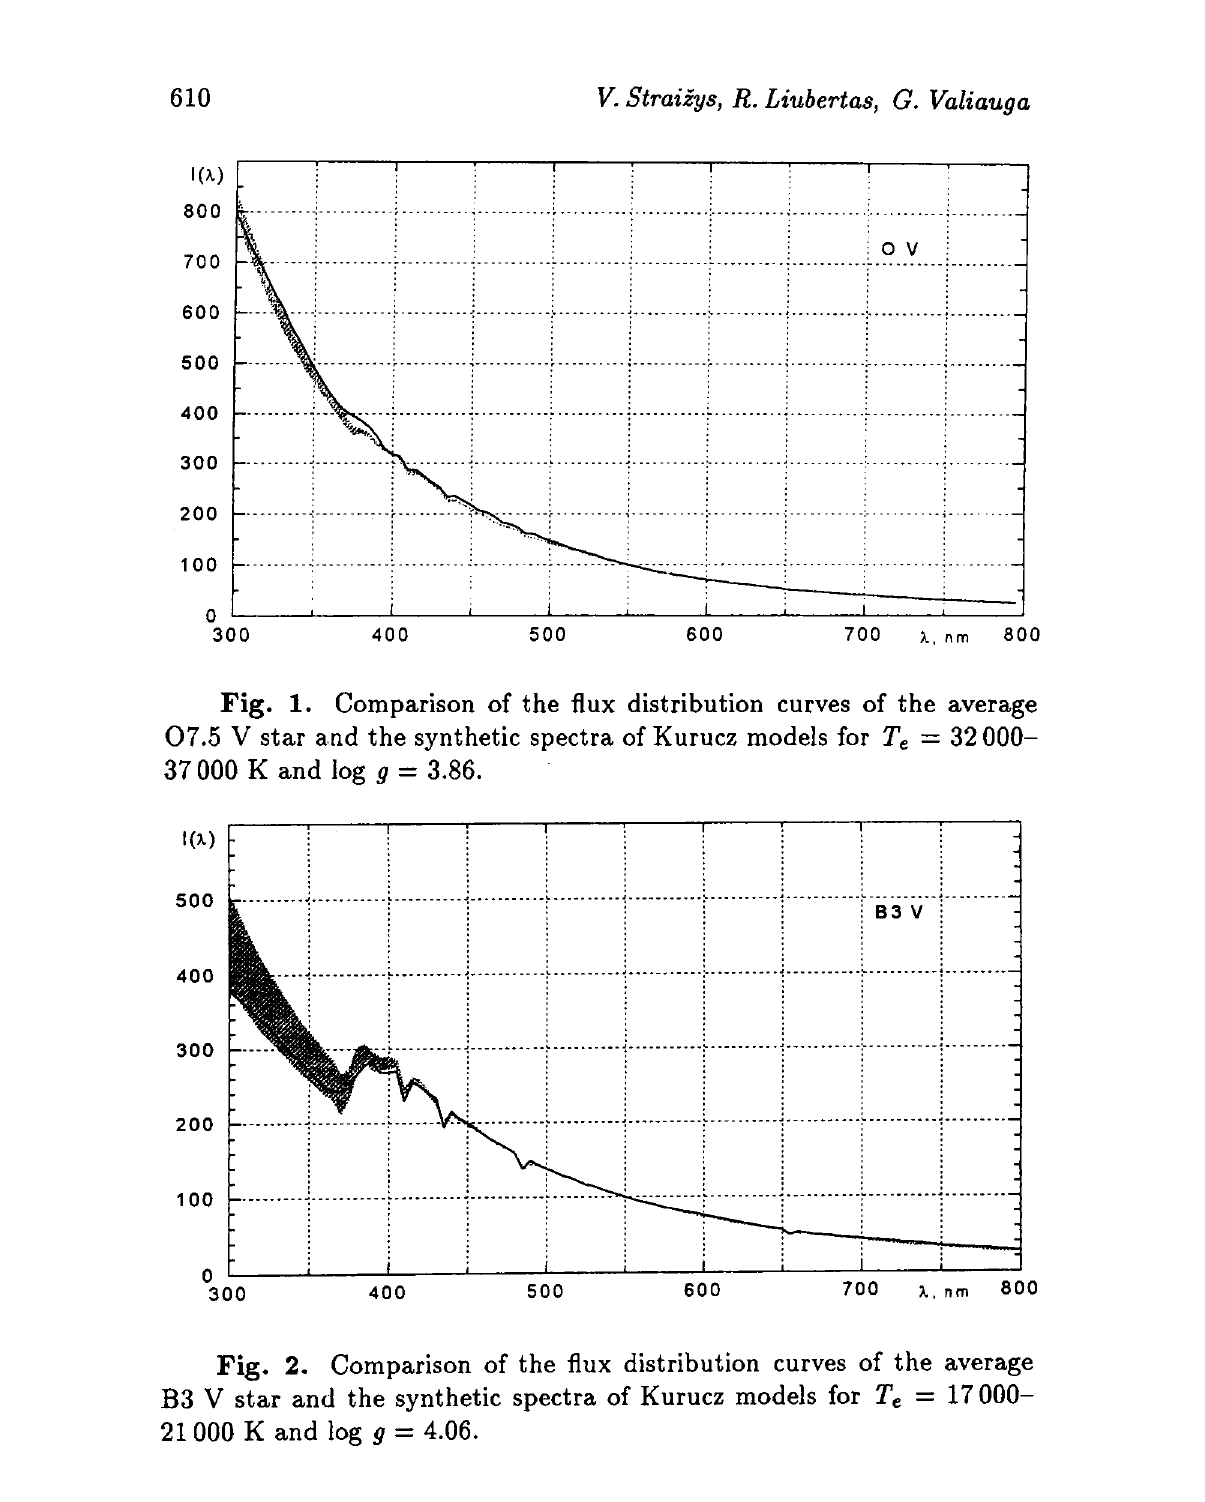
Fig. 2. Comparison of the flux distribution curves of the average B3 V star and the synthetic spectra of Kurucz models for T e = 17 000- 21 000 K and log g =